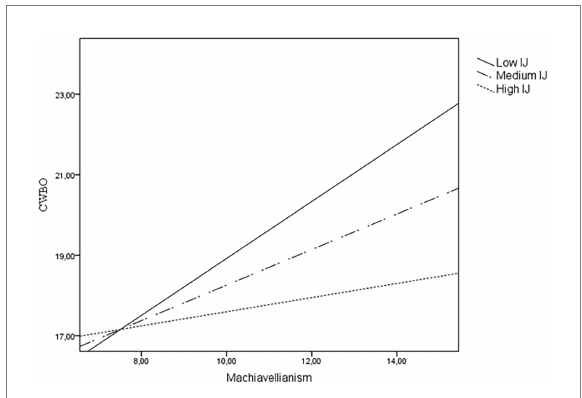
FIGURE 2 Moderating effects of perceived interactional justice (IJ) on the relationship between Machiavellianism and counterproductive woek behaviors targeting the organization (CWBO).